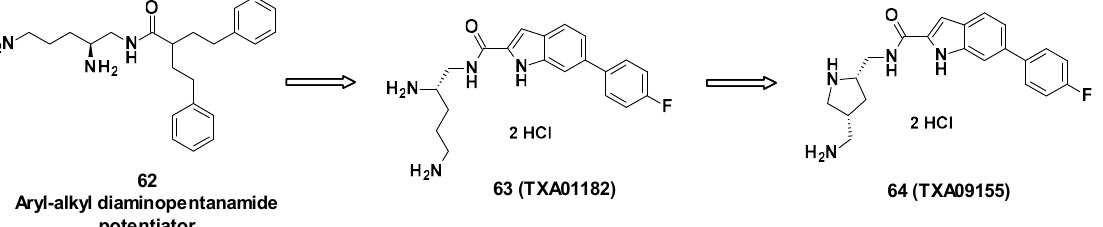
Figure 11. Structure of TXA09155 ( 64 ), TXA01182 ( 63 ) and 62 , one of the aryl-alkyl diaminopentanamide potentiators.